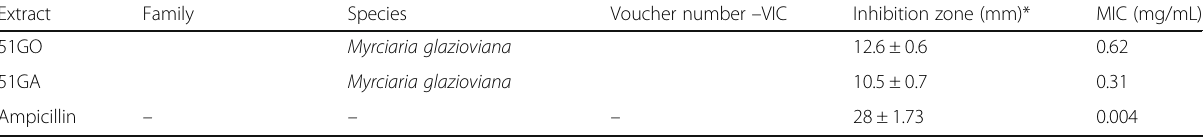
Table 1 Antimicrobial activity of plant extracts against Staphylococcus aureus ATCC 29213 (Continued) Extract